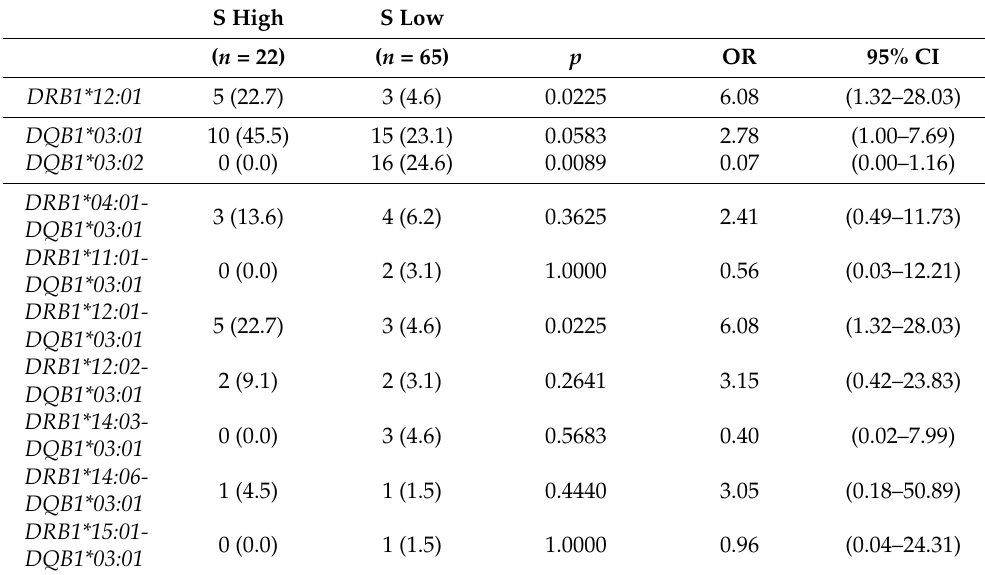
Table 2. HLA allele or haplotype carrier frequencies in RA patients with higher or lower titers of anti-SARS-CoV-2 S Abs.